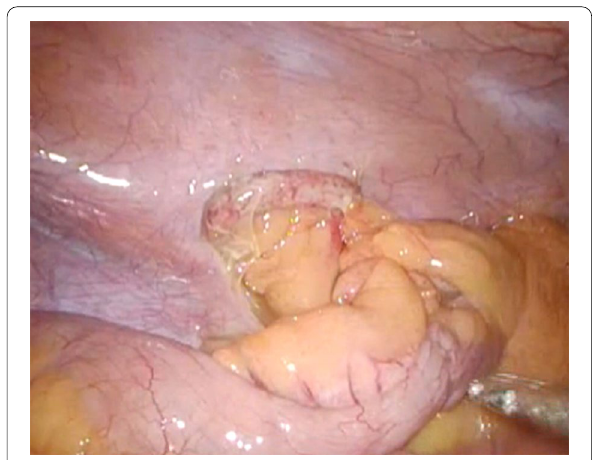
Fig. 2 Intraoperative findings. At surgery, the appendix was swollen, and the thickened mesoappendix was adherent to the pelvic